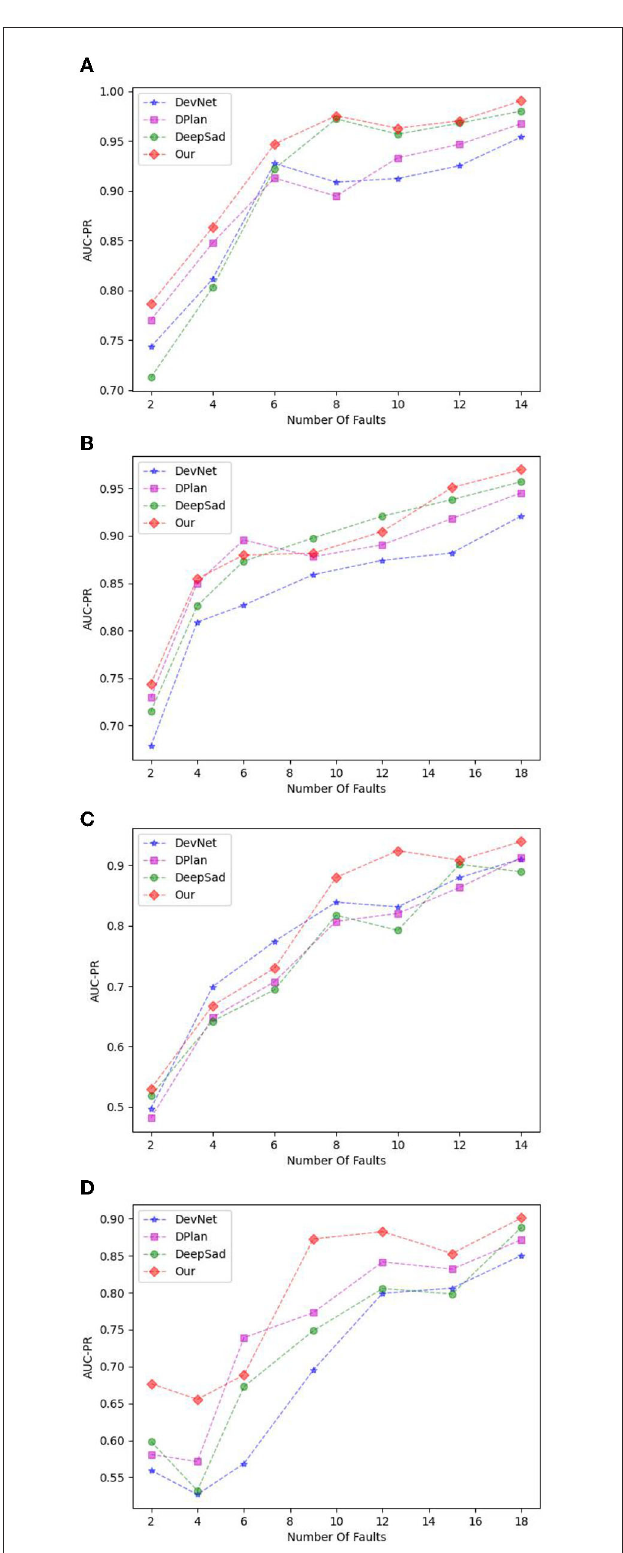
FIGURE6 (A) The result of cooler degradation. (B) The result of valve degradation. (C) The result of internal pump leakage. (D) The result of accumulator leakage.